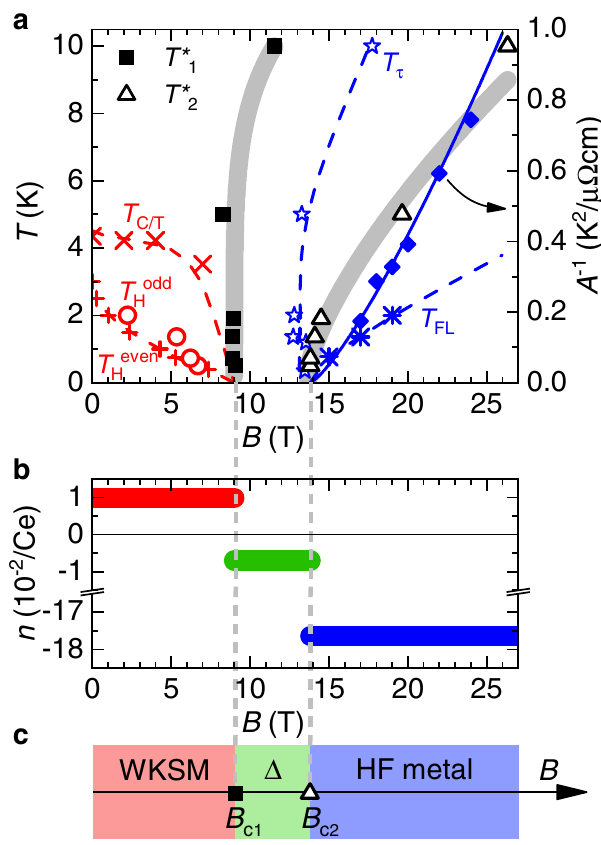
Fig. 4 | Magnetic- fi eld tuned phase diagram of Ce 3 Bi 4 Pd 3 . a Temperature- magnetic fi eld phase diagram with the crossover temperatures T * 1 and T * 2 (from Fig.2c),thetemperaturescales T C/T , T even H ,and T odd H (allfromFig.1)associatedwith the Weyl-Kondo semimetal phase, the characteristic scales T τ of the torque signal and T FL of Fermi liquid behavior (both from Fig. 3) (all left axis). The inverse A coef fi cient (from Fig. 3) is plotted on the right axis, indicating an effective mass divergence at B c2 . b Effective charge carrier concentration in a single-band model, n =1 = ð ~ Re Þ , at the lowest temperature of 0.5K (from Fig. 2d), in the three different magnetic fi eld ranges. c Axisacross a theoretical zero-temperaturephase diagram. AtopologicalquantumphasetransitionbetweenaWeyl-Kondosemimetal(WKSM) andaphasewithannihilatedandthusgapped-outWeylnodes( Δ )occursat B c1 .The underlying Kondo insulator gap persists across both the WKSM and the Δ phase, and is quenched only at a quantum critical point at B c2 to reach a heavy fermion (HF) metal phase at high fi